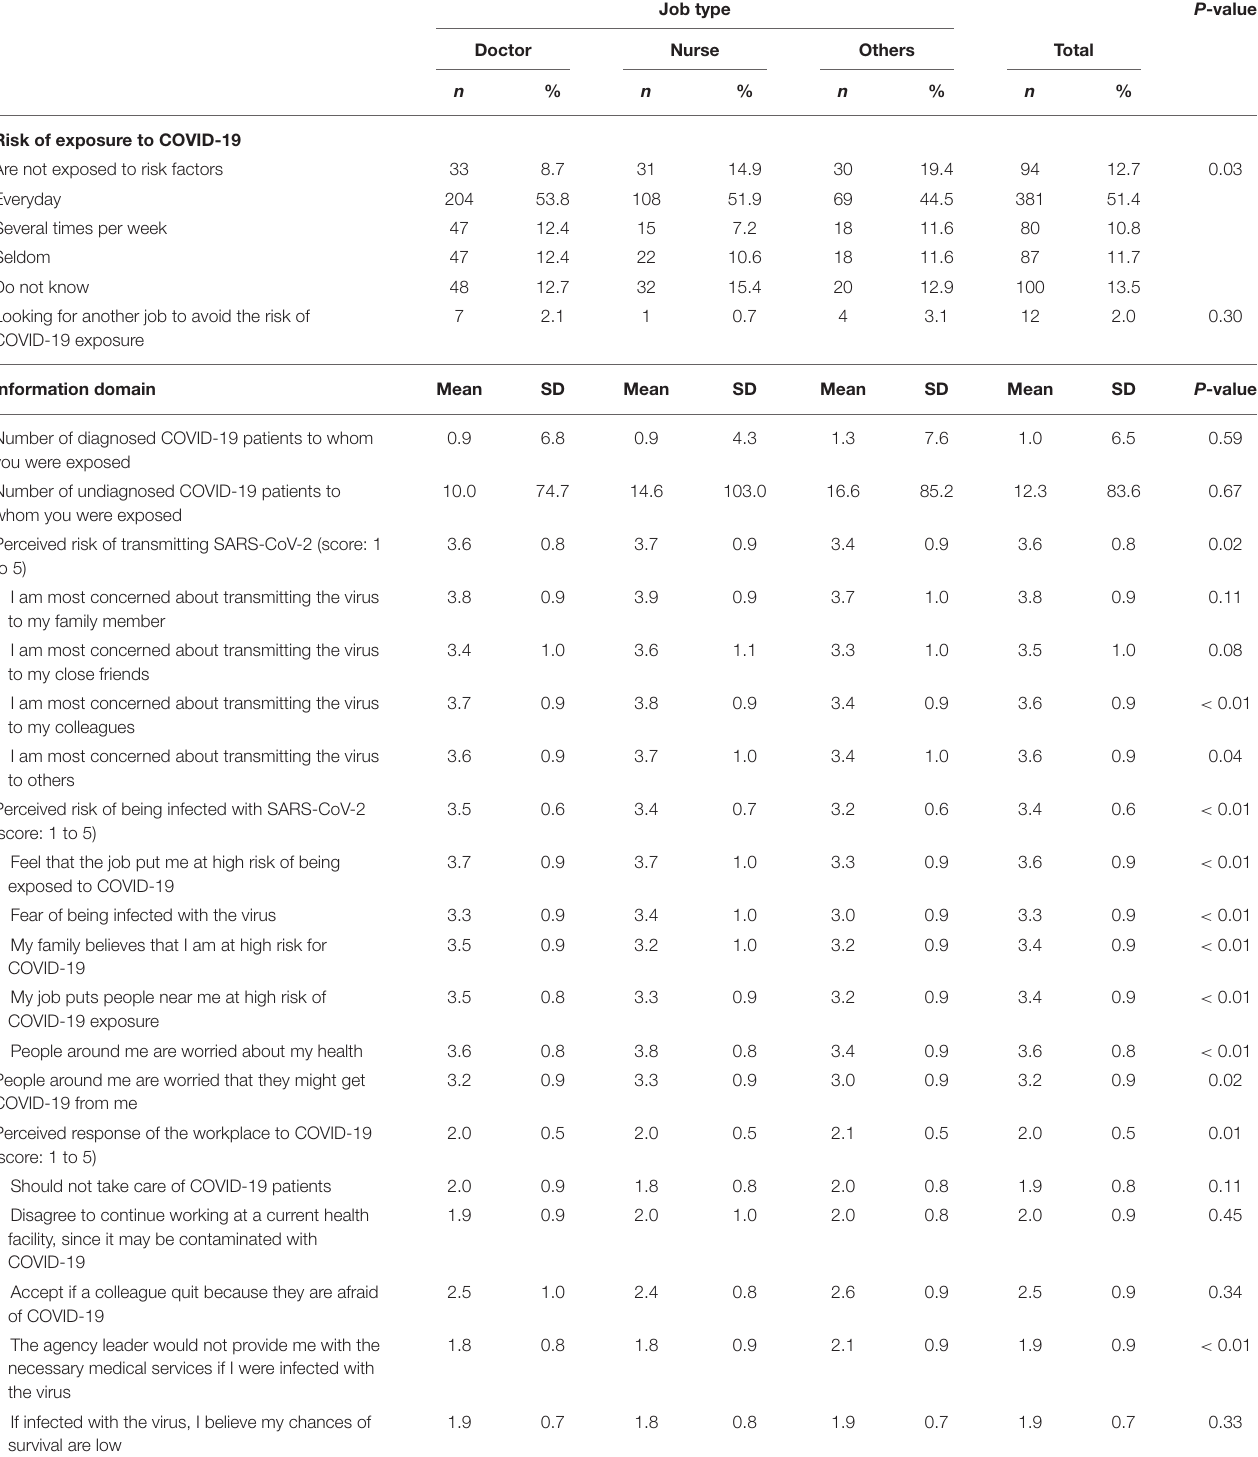
TABLE 3 | Perception regarding the risk of exposure to